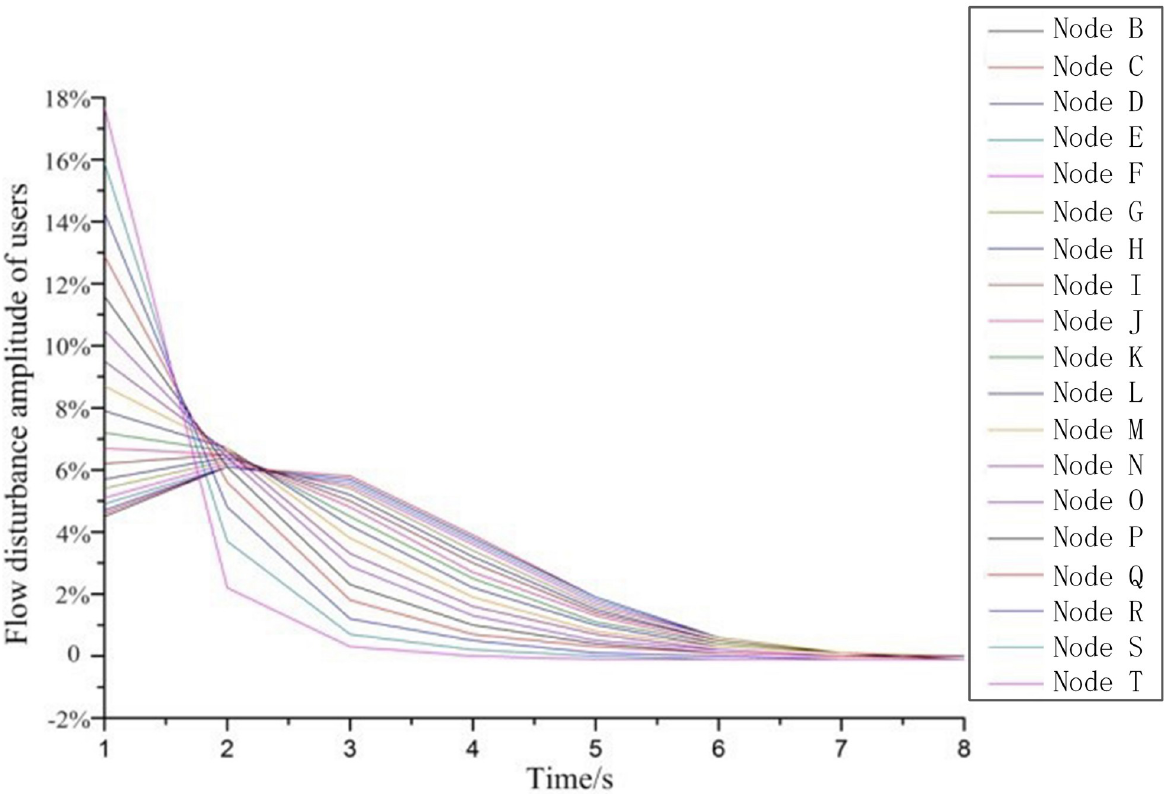
Fig 3. The user’s per second flow disturbance amplitude when leakage occurs at different nodes after